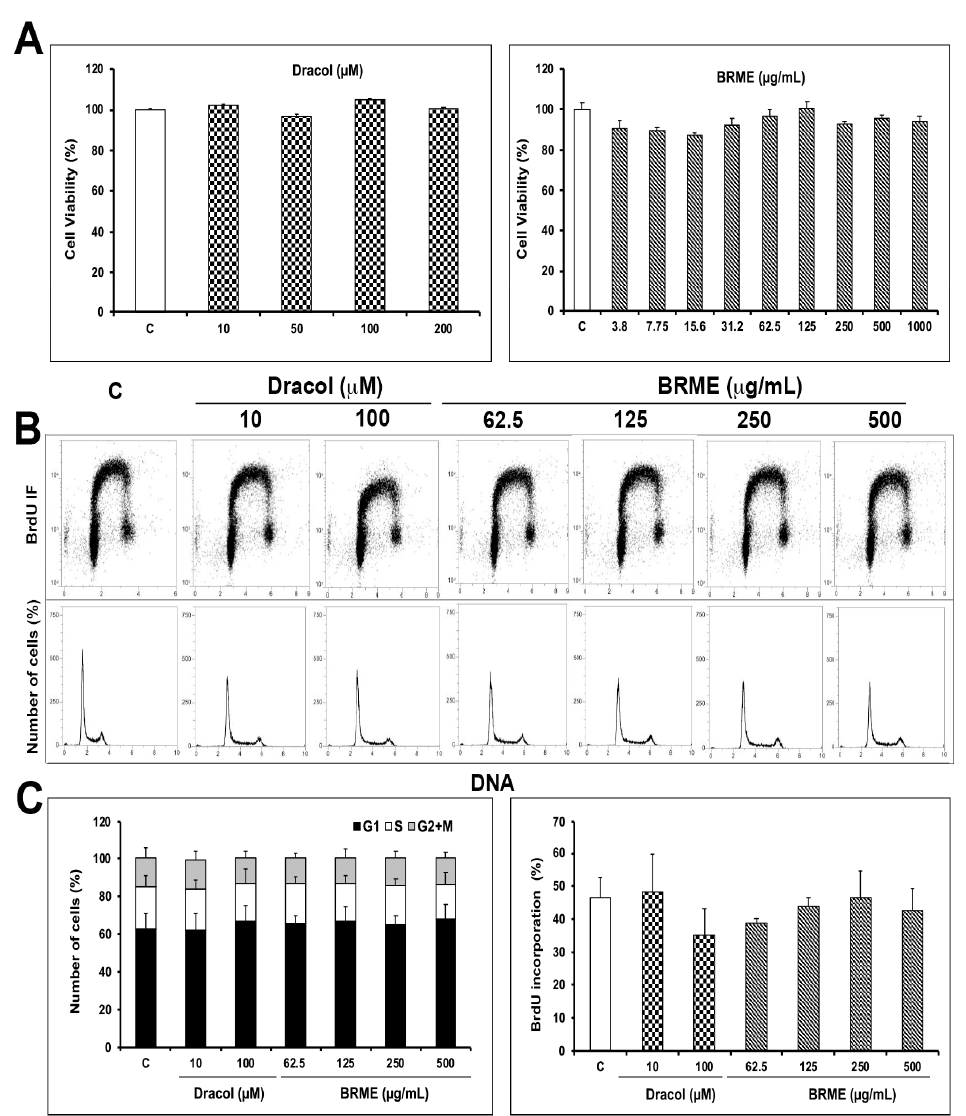
Figure 2. Assessment of THP1 cell viability and proliferation after Dracol and BRME treatment. ( A ) Effect of 24 h treatment with increasing concentrations of Dracol and BRME on THP1 viability as evaluated by MTT assay. Values are expressed as percentage of untreated cells (control). All results are expressed as mean ± SD from three independent experiments. ( B ) Cell cycle phase distribution was evaluated by flow cytometry after BrdU incorporation analysis and staining with PI. Ten thousand cells were analysed from each sample, and statistical analysis of the mean fluorescence intensity was performed with Attune ™ NxT Software . (C) DNA synthesis was analysed by a biparametric flow cytometry analysis of BrdU incorporation versus DNA content. Representative profiles of cell